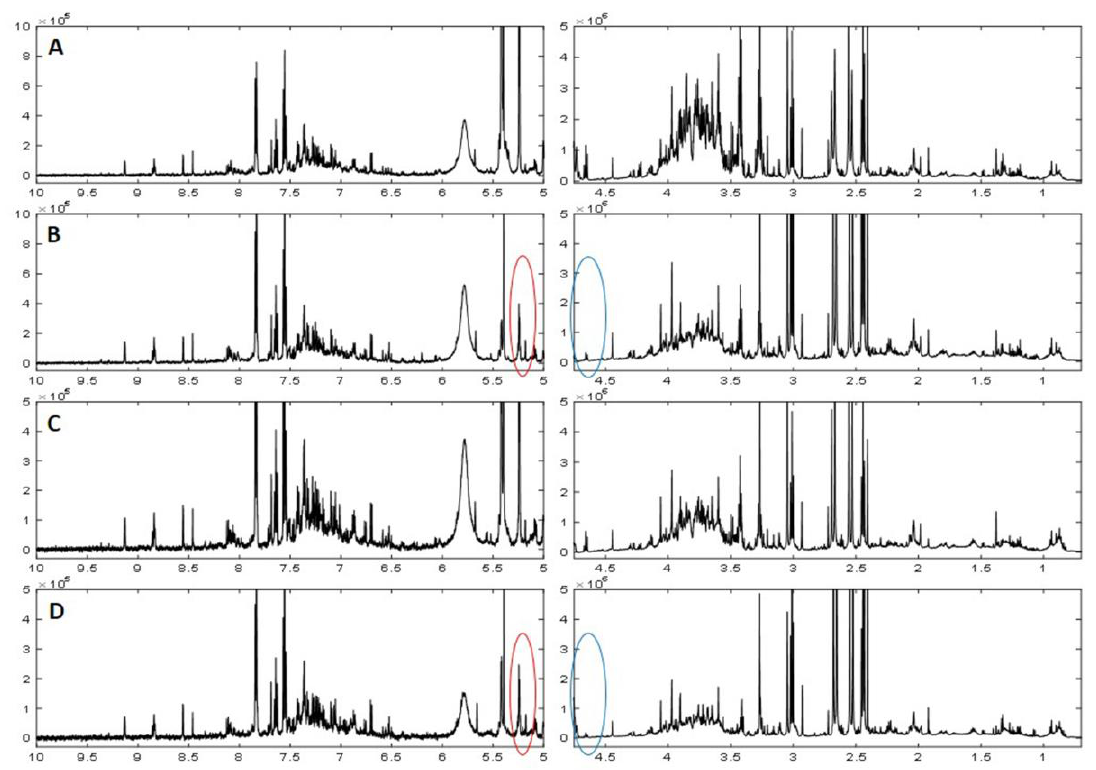
Figure 4. The 600 MHz 1 H-NMR spectra of urinary samples collected over 24 h at day 14 from ( A ) control, ( B ) MSG-fed, ( C ) NaCl-fed, and ( D ) NaHCO 3 –fed rats ( n = 10 per group).